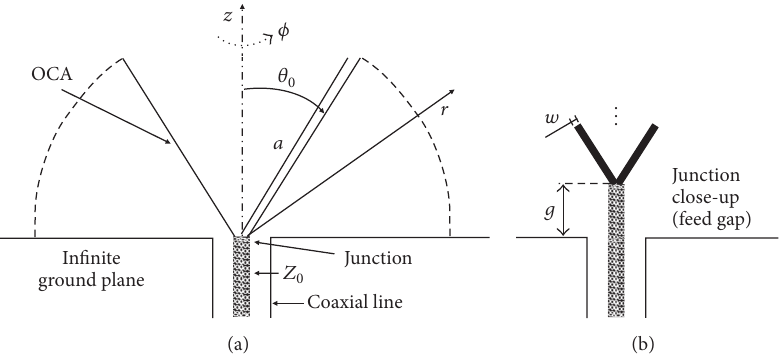
Figure 9: (a) Vertical plane cut of an OCA fed by a coaxial feed line and (b) a close-up of its junction. The antenna is a body of revolution over the 𝑧